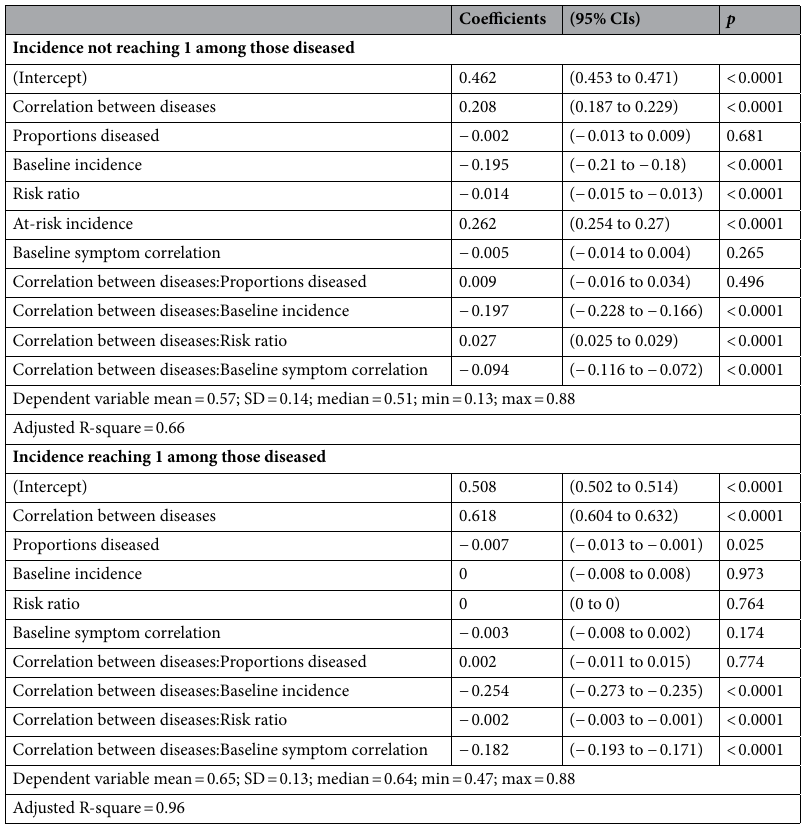
Table 11. Effects of the correlations between diseases, baseline incidence, proportions diseased, risk ratios, and baseline symptom correlations on the areas under curves obtained from the maximal area under the receiver operating characteristic curve using at most 40 symptoms to predict the disease associated with the disease that caused symptoms. CI confidence interval, SD standard deviation.